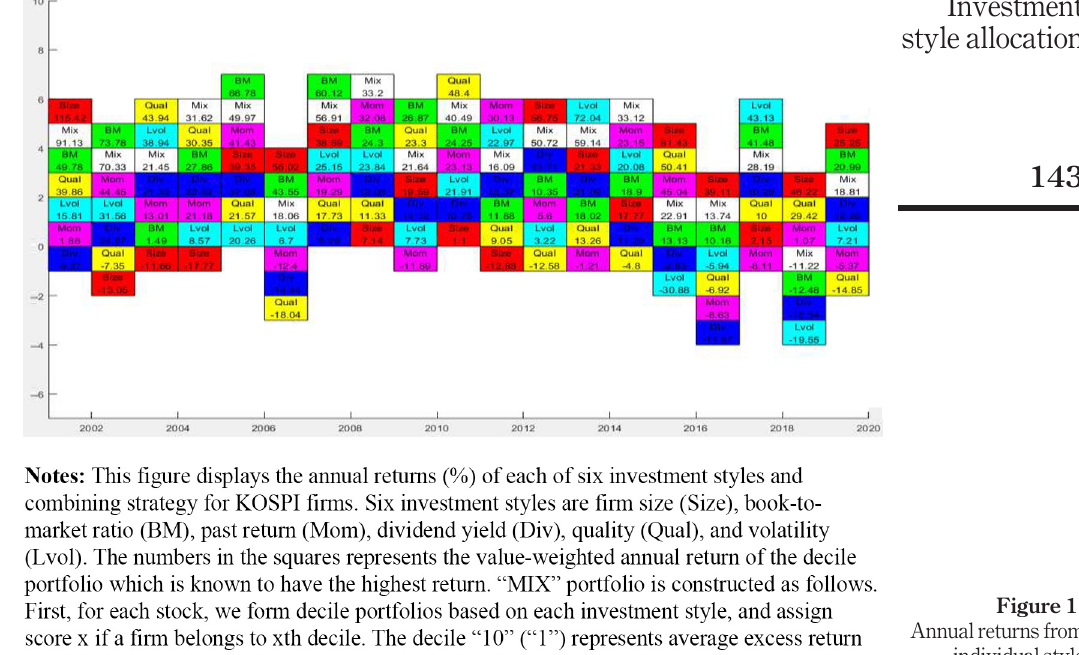
Figure 1. Annual returns